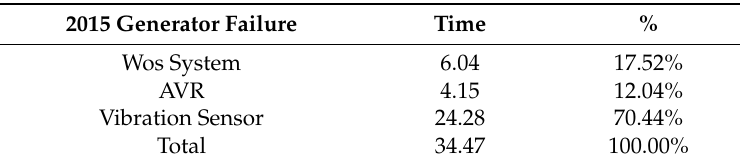
Table 6. Statistical analysis of failure time data, December